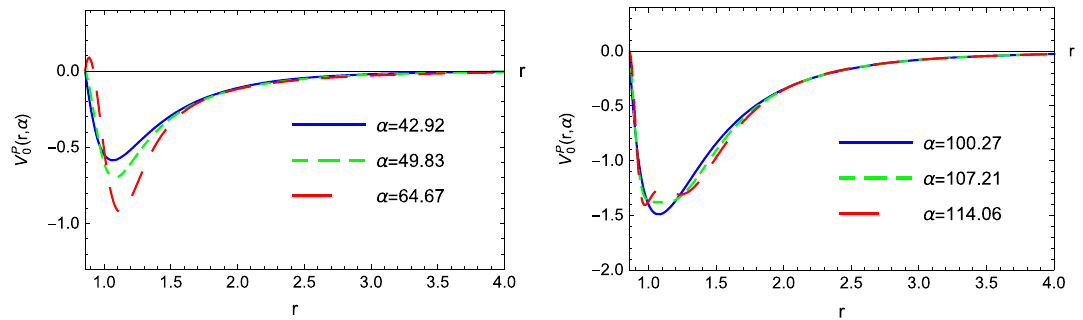
( r ,α) for l = 0 scalar around (Left) n = 1 (α ≥ 40 . 84 ) black hole and (Right) n = 2 (α ≥ 99 . 89 ) black 0